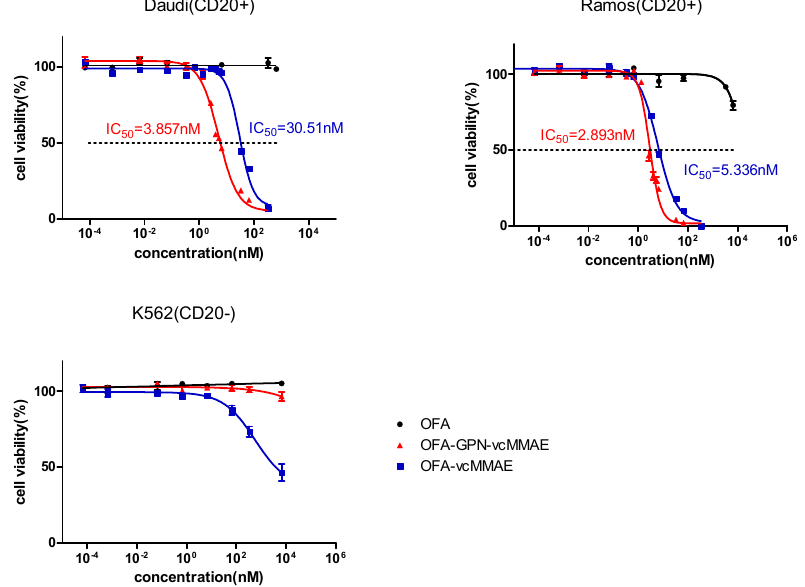
Figure 10. In vitro toxic effects of OFA-GPN-vcMMAE, OFA-vcMMAE and unconjugated OFA on CD20-positive (Daudi, Ramos) and negative (K562) cell lines. CD20+: CD20-positive; CD20-: CD20- negative.